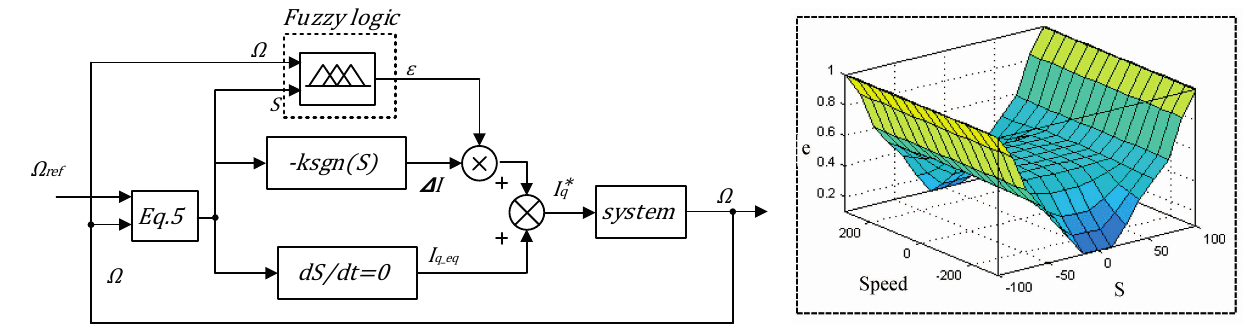
Figure 3. The proposed SMC scheme and the fuzzy logic control surface.